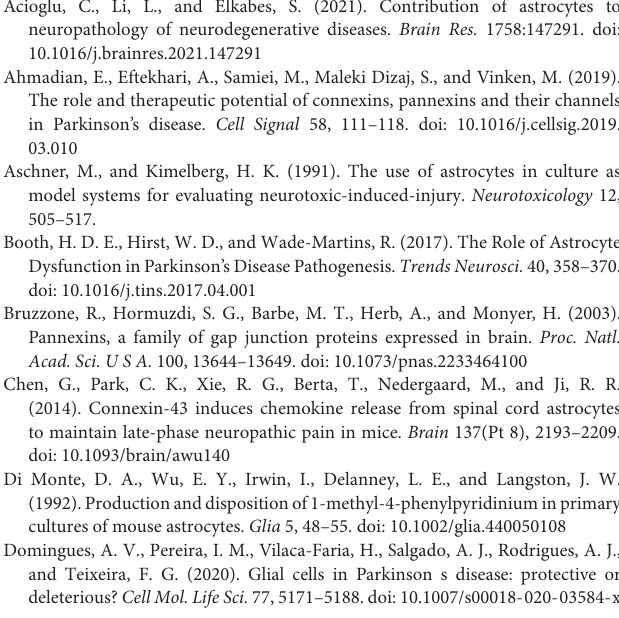
Supplementary Figure 4 | The effect of Panx 1-targeting siRNA on Panx 2 and Panx 3 expression in cultured primary astrocytes. The data were normalized to the scramble siRNA group level. Supplementary Figure 5 | qPCR analysis of IL-1 β , IL-6, and TNF- α expression after treatment with scrambled or Panx 1-targeted siRNA alone in primary cultured astrocytes. The data were normalized to control group levels. Supplementary Figure 6 | qPCR analysis of Panx 2 and Panx 3 expression after 100 ng/ml LPS treatment in primary cultured astrocytes. The data were normalized to control group levels. Supplementary Figure 7 | Analysis of the selected inflammatory cytokine mRNA expression by qPCR assay, including IL-1 β (A) , IL-6 (B) , TNF- α (C) , TGF- β (D) , and IL-10 (E) in primary cultured astrocytes. Cells were pretreated with Panx 1 inhibitor CBX (100 mM, 60 min) alone or LPS treatment (100 ng/ml, 24 h). The levels were displayed as percentage of the control (the same volume of DMSO). The data were normalized to 18S mRNA levels, n = 3. All data are mean ± SEM. Statistical comparison were performed using one-way ANOVA, following by Newman–Keuls Multiple Comparison Test. ∗ p < 0.05, ∗∗∗ p < 0.001